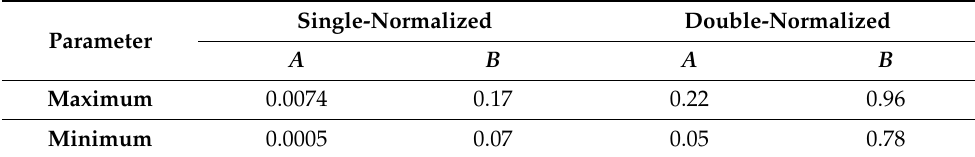
Table 4. Maximum and minimum values of medium sand.